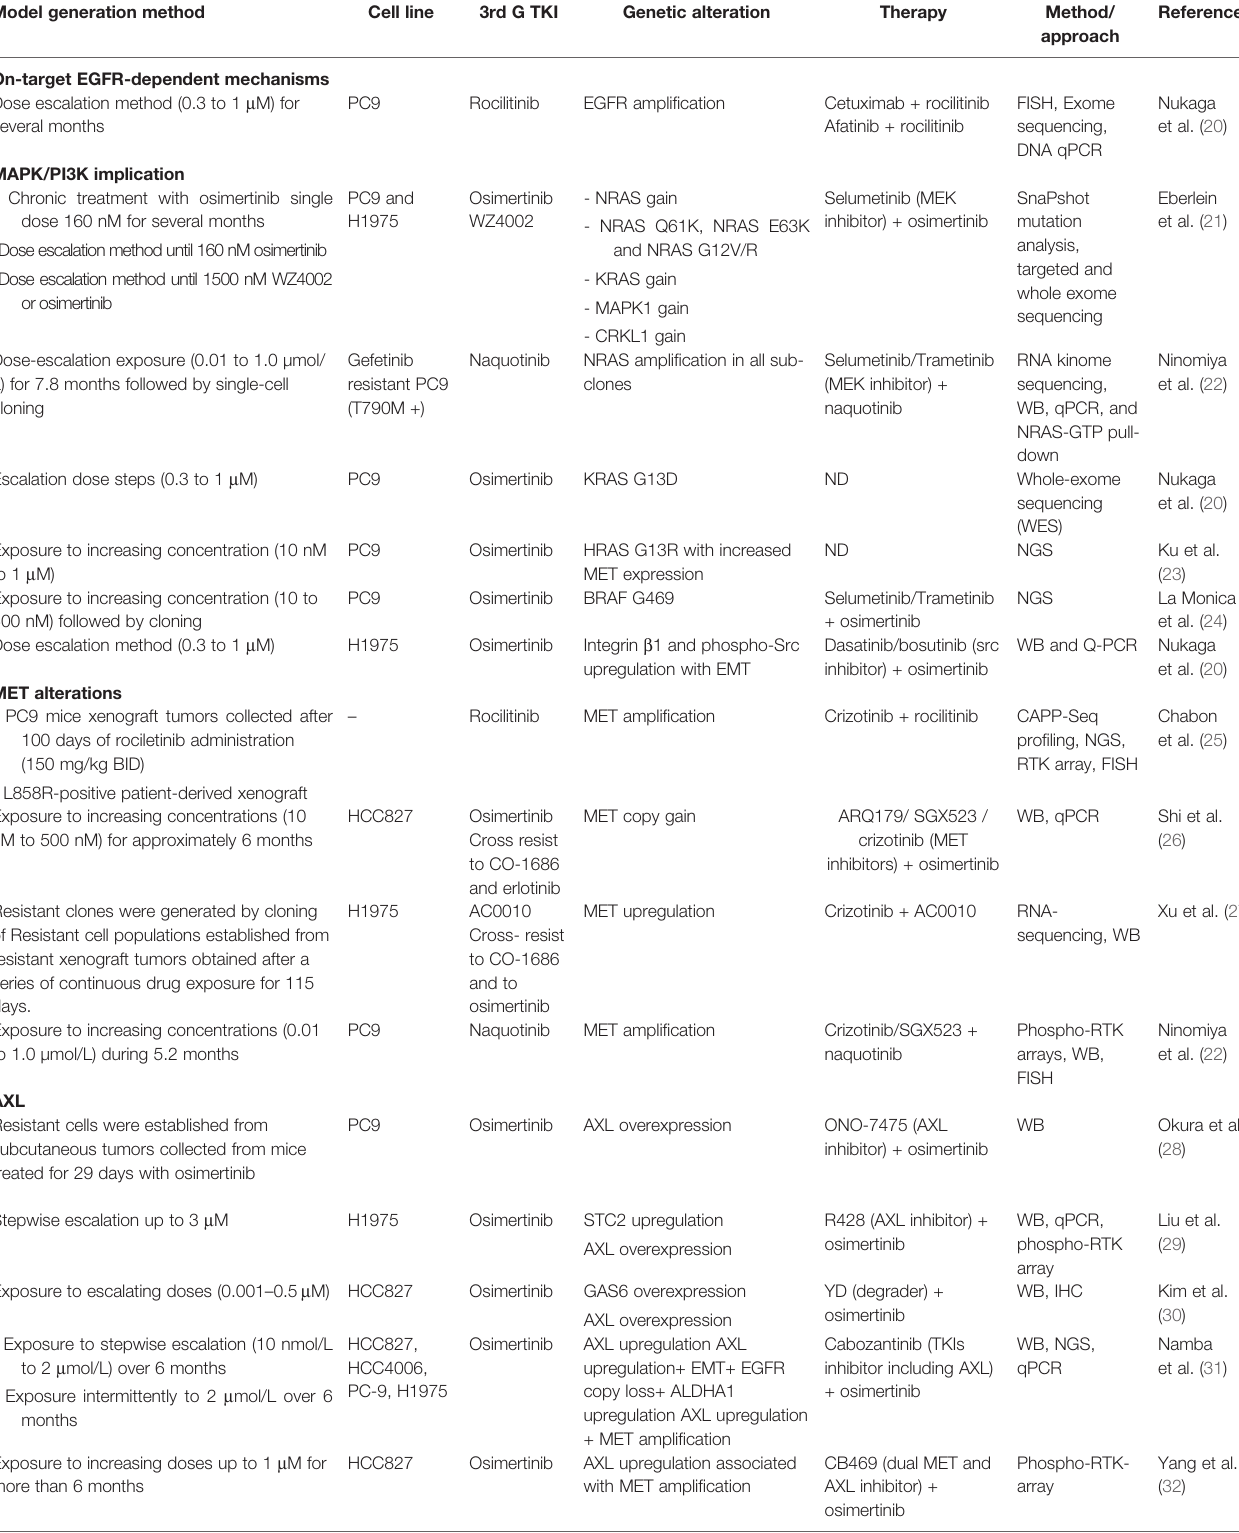
TABLE 1 | Preclinical models of resistance to third-generation